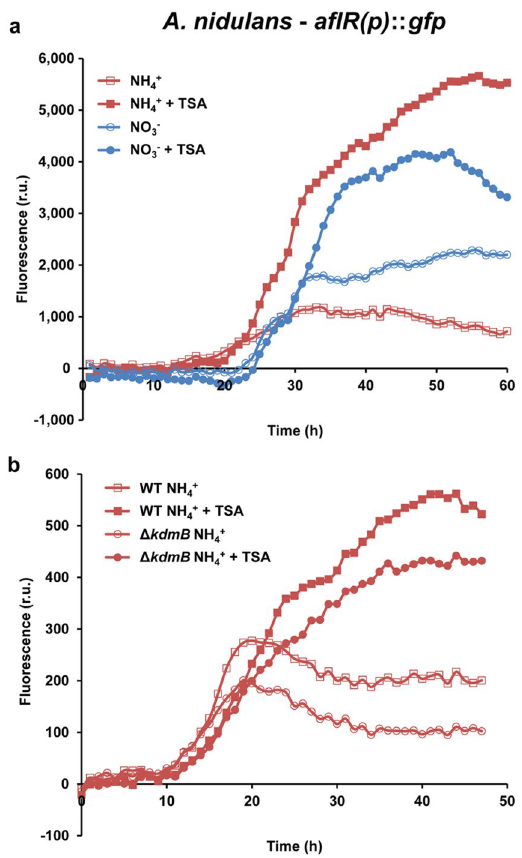
Figure 5. Hourly monitoring of the expression of the secondary metabolite genes during the entire fungal life cycle. Monitoring expression of aflR . ( a ) A . nidulans aflR(p)::gfp was grown on solid minimal media with ammonium (repressing) or nitrate (inducing) as sole nitrogen source. Media was supplemented with 0 µ M or 1 µ M trichostatin A (TSA), a histone deacetylase inhibitor known to increase SM gene expression of some SM gene clusters. ( b ) A . nidulans aflR(p)::gfp in a wild type (WT) or Δ kdmB mutant background were grown on solid minimal media with ammonium as sole nitrogen source at 37°C. Fluorescence and hence aflR expression is decreased upon deletion of kdmB . Addition of TSA increased the expression of aflR in both the wild type and the Δ kdmB mutant, as shown by an increase in the fluorescence readings. Growth and GFP fluorescence were monitored in parallel. Hyphal growth was only slightly affected upon deletion of kdmB as well as TSA treatment, as shown in the corresponding growth curves in Supplementary Fig. 4. The diagrams depict representative examples of the fluorescence patterns as the average from 3–4